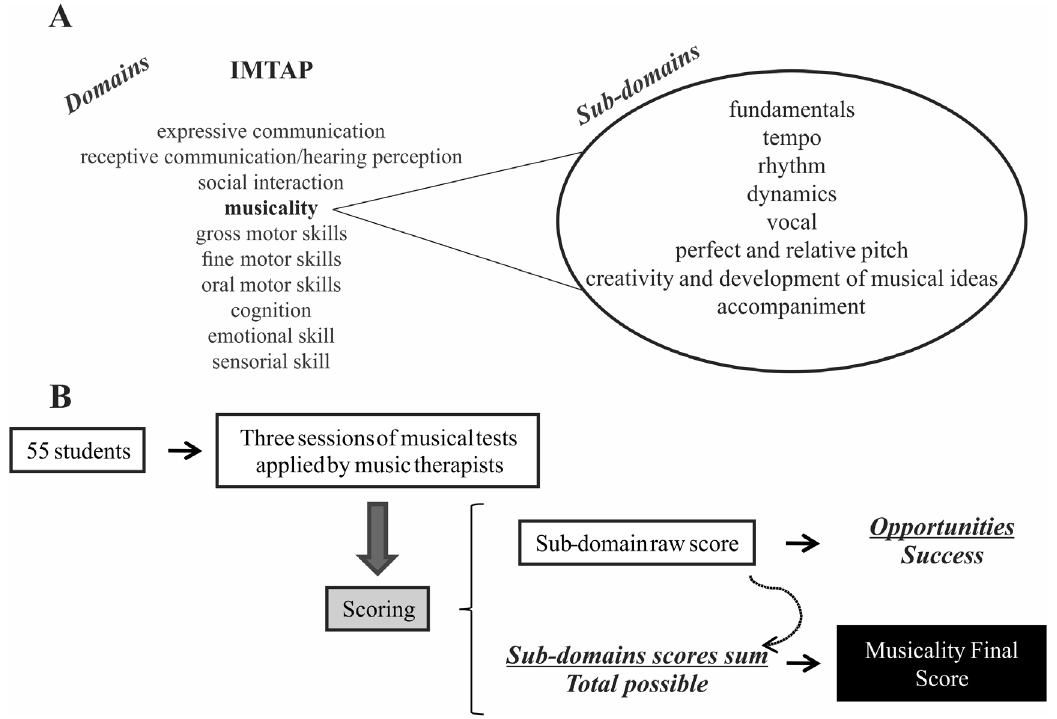
Figure 1 - Representation of IMTAP assessment. (A) The IMTAP evaluates 10 musical and/or behavioral domains. In this study, we analyzed the musi- cality domain, which is assessed through different sub-domains; (B) the scheme for musicality assessment and scoring used in this